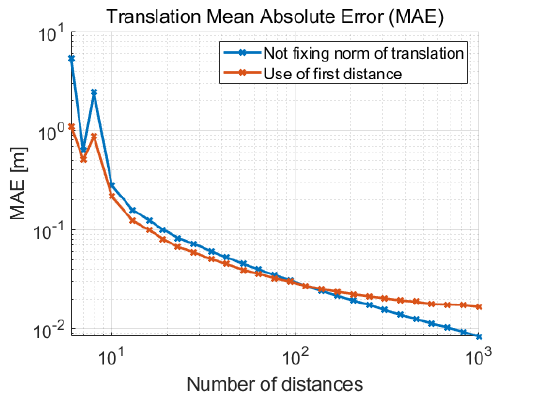
Figure 7. Mean absolute error (MAE) of the translation in 3D as a function of the number of distance measurements with standard deviation σ d =